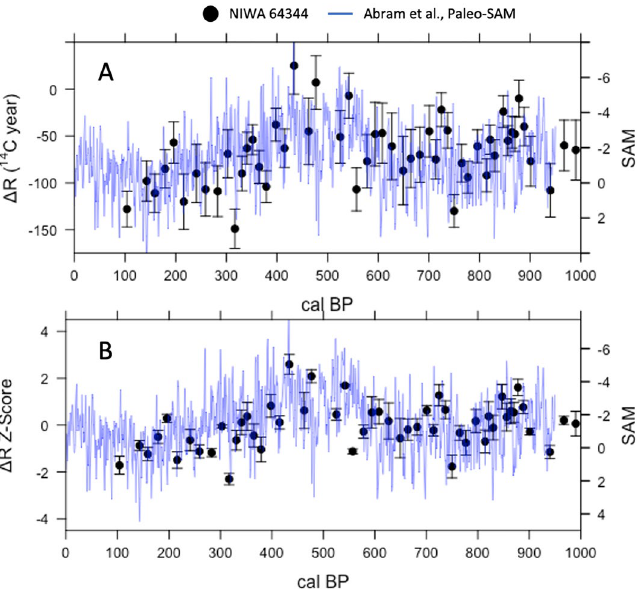
Figure 2. Subtropical SPG ∆R Variability and Paleo-SAM over the last Millennium. ( A ) A comparison of black coral ∆R values for the East Auckland Current (black dots—NIWA 64344) with the paleo-SAM index from Abram et al. 39 (blue line). ( B ) A comparison of ∆R normalized Z-scores (black dots) against Paleo-SAM (blue line). All uncertainties shown are 1σ, are calculated using the Reimer et al. 37 methodology, and reflect the uncertainty in the radiocarbon age and U-Th calendar